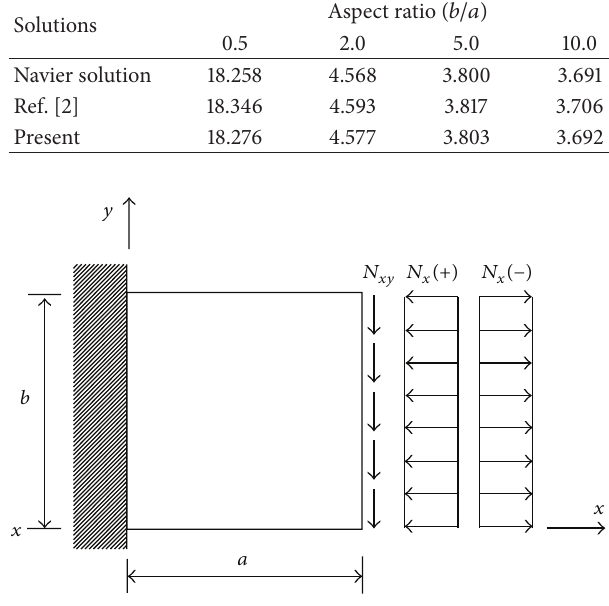
Figure 6: FGM cantilever plates under combined